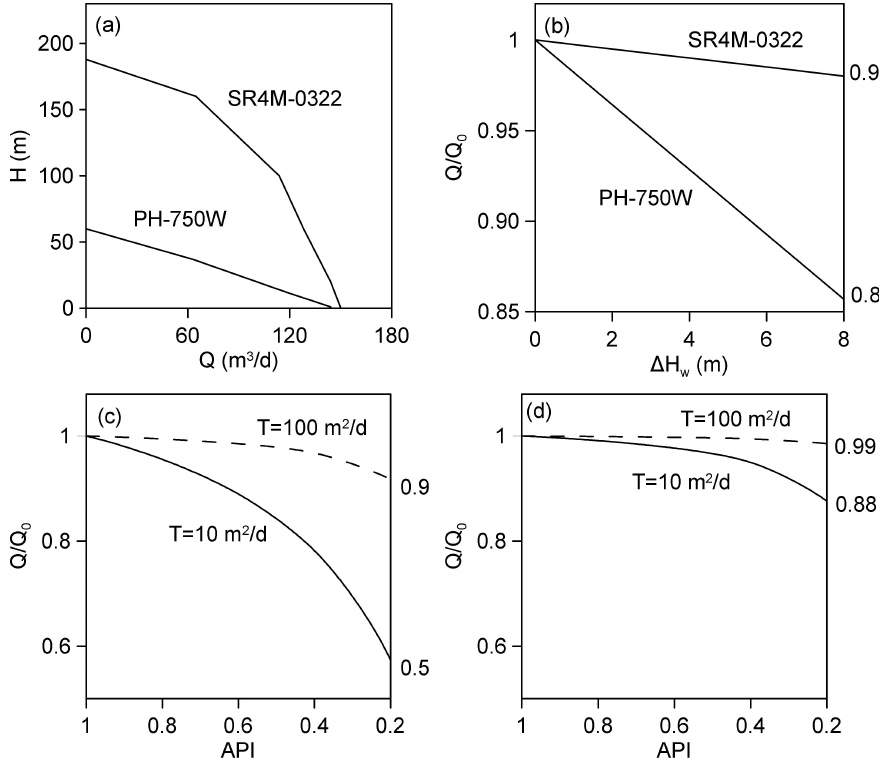
Figure 8. ( a ) Pump performance curves for centrifugal-type (PH-750W) and underwater-type (SR4M- 0322) pumps; changes in pumping rates due to the decline in groundwater level after opening the weir: ( b ) without a change in API (API = 1); and due to a decreased API at ( c ) the centrifugal pump, and ( d ) the underwater pump.